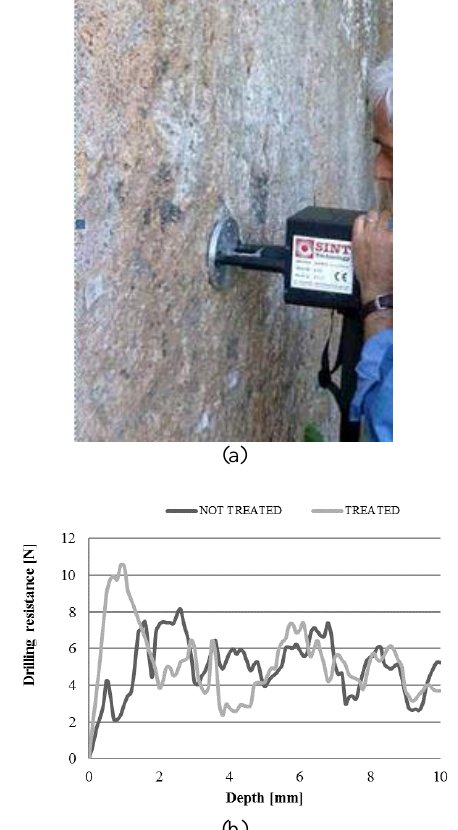
Figure 12. Archaeological Etruscan area of Sovana. (a) Drilling test and (b) cohesion profiles on the area treated with an acrylic